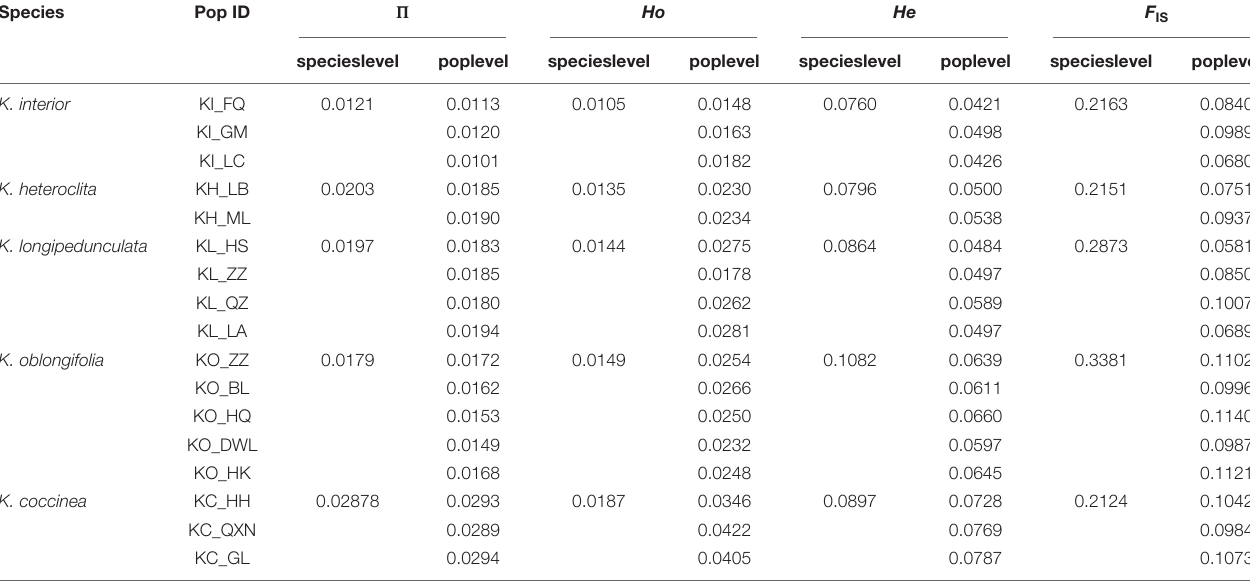
TABLE 2 | Population statistics calculated for the RAD-seq loci.